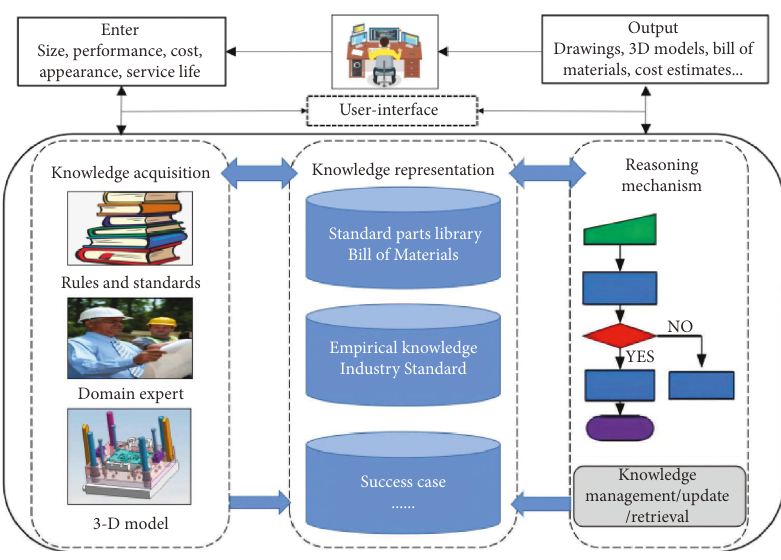
Figure 2: KBE system structure frame